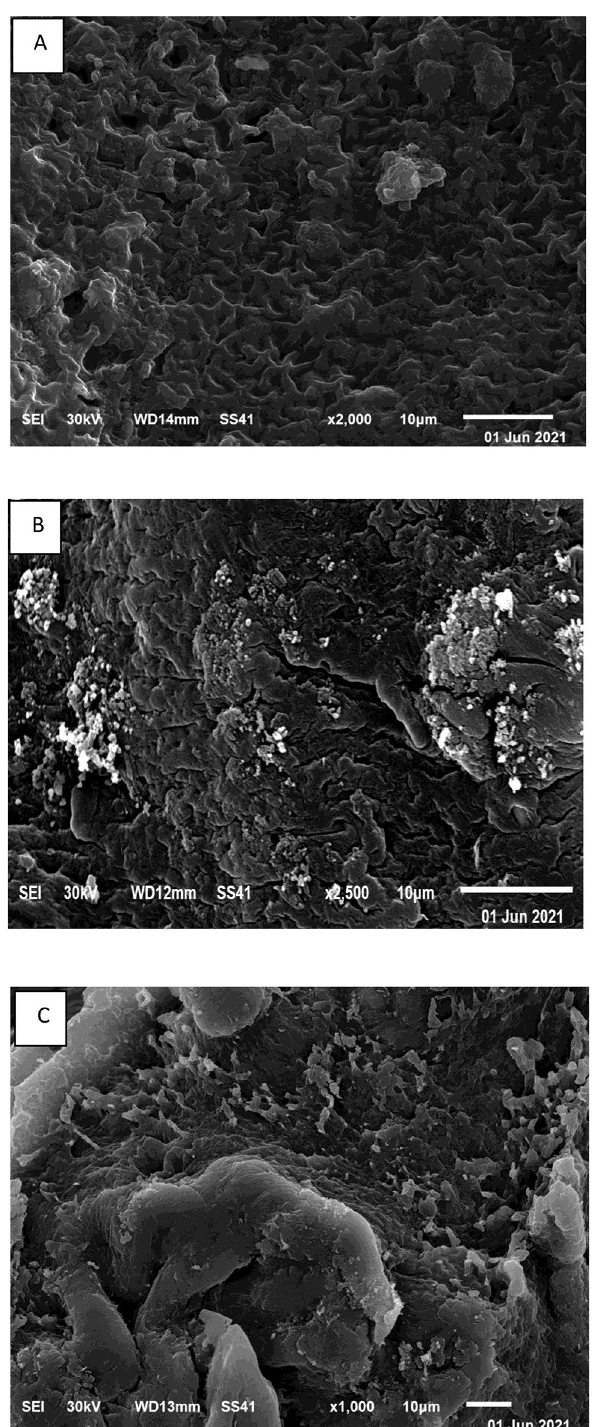
( B ) and Ca-alginate-immobilized T. ornata cells ( C